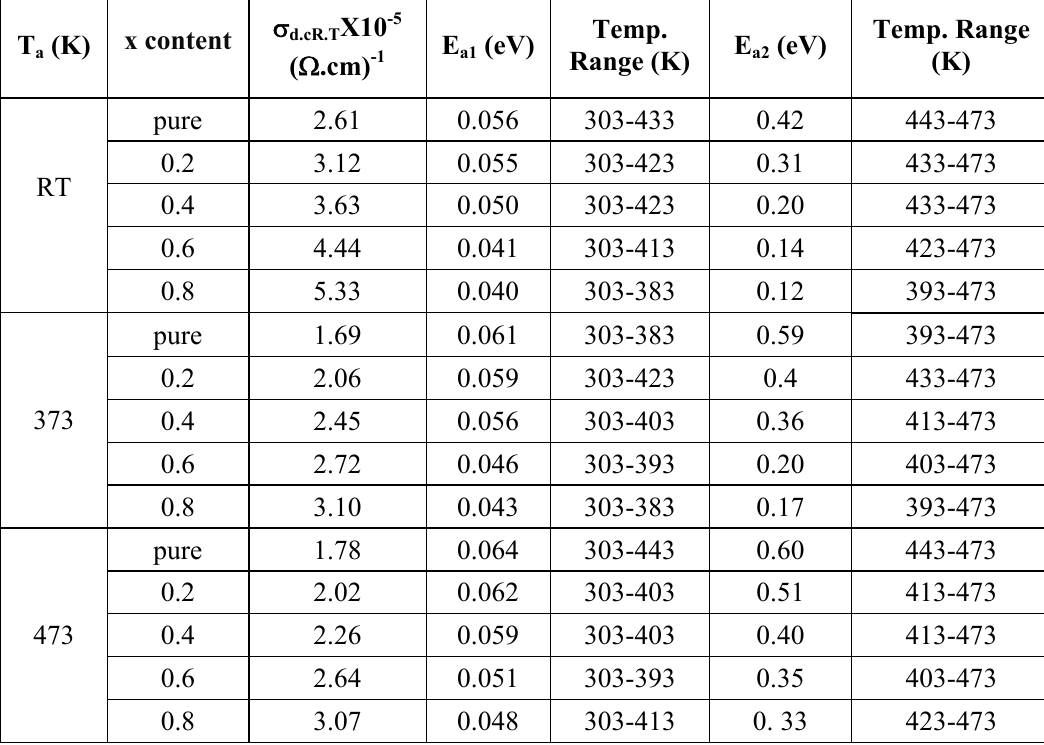
Zn O films at different x content and x 1-x annealing